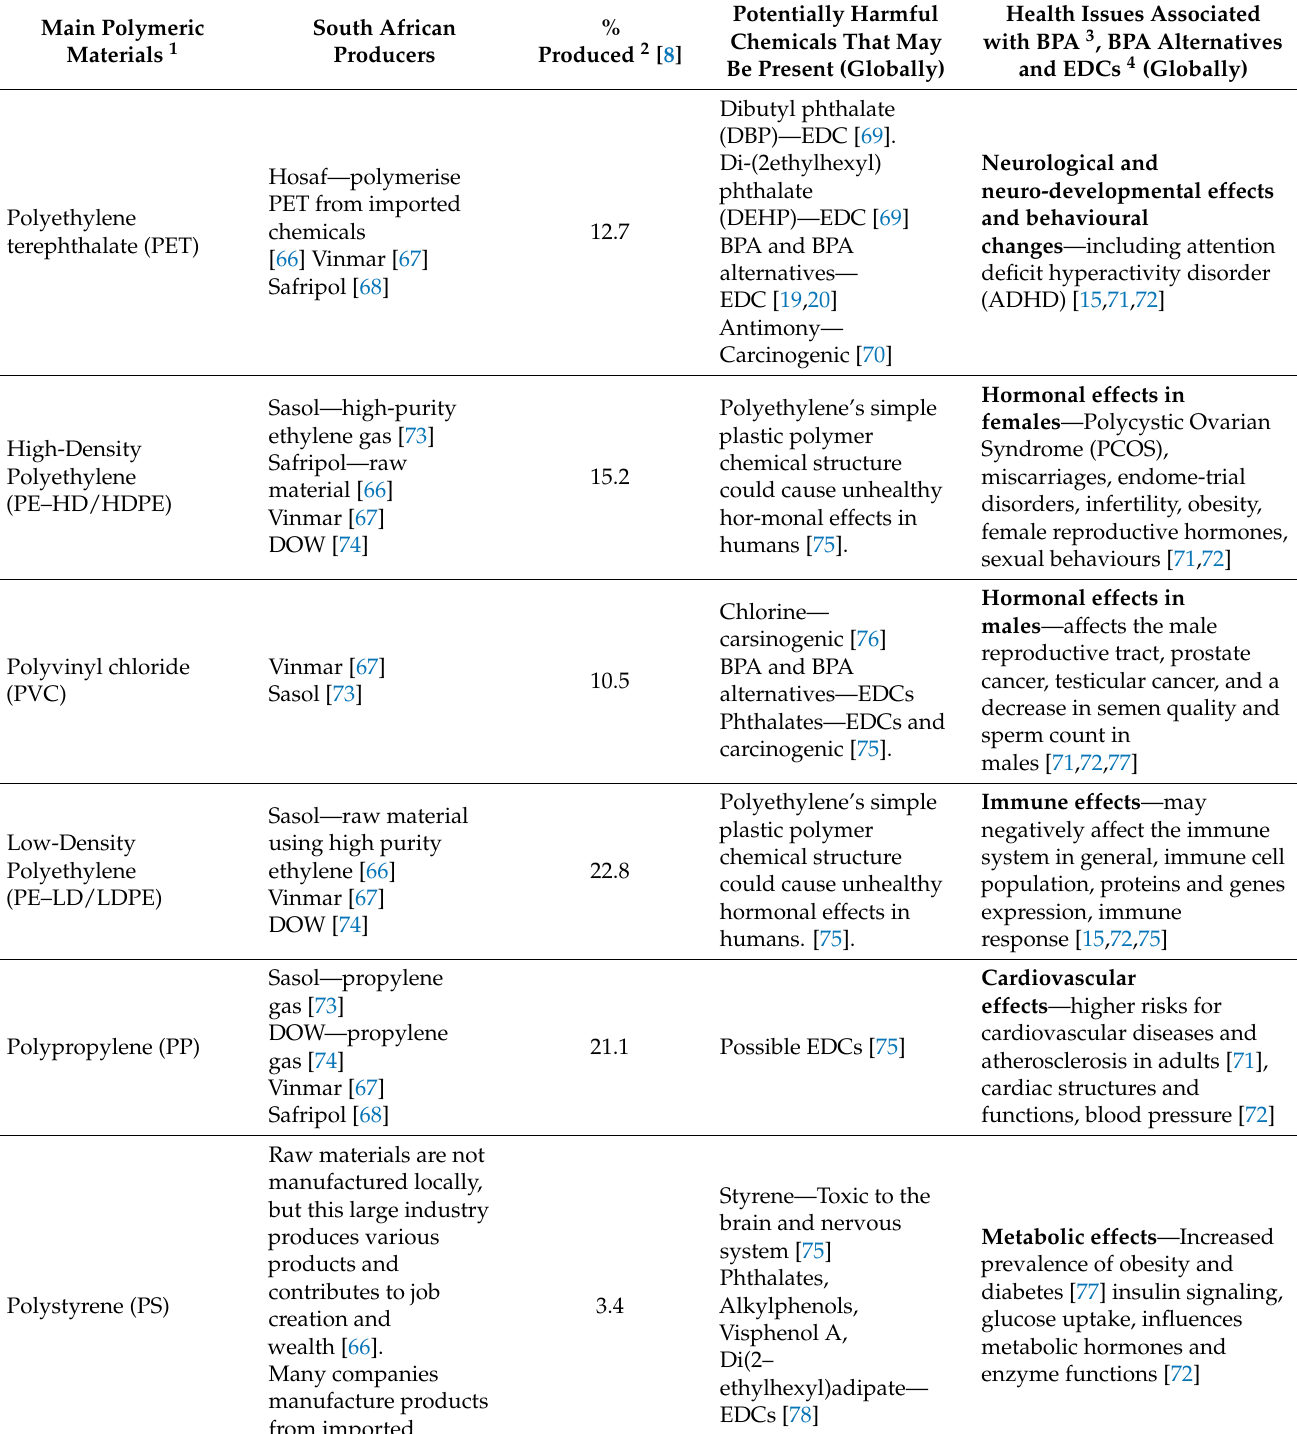
Table 1. Summary of plastic polymetric materials in South Africa and potential health